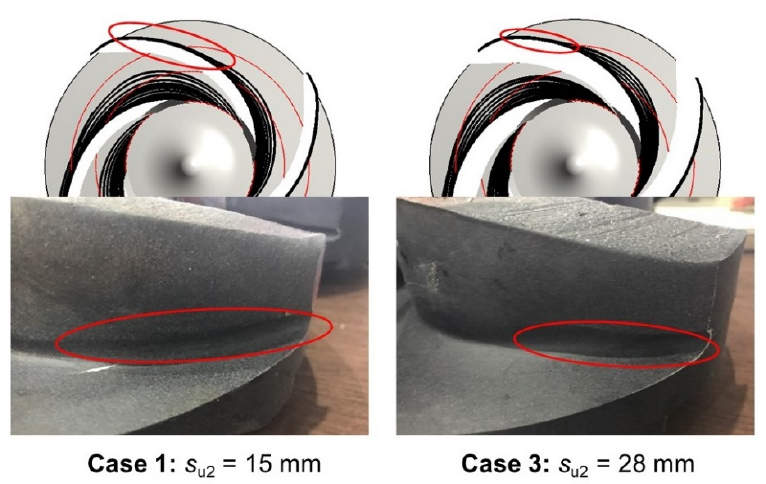
Figure 9. Comparison of the solid particle trajectories and the wear patterns on the pressure sides of the tested impellers.